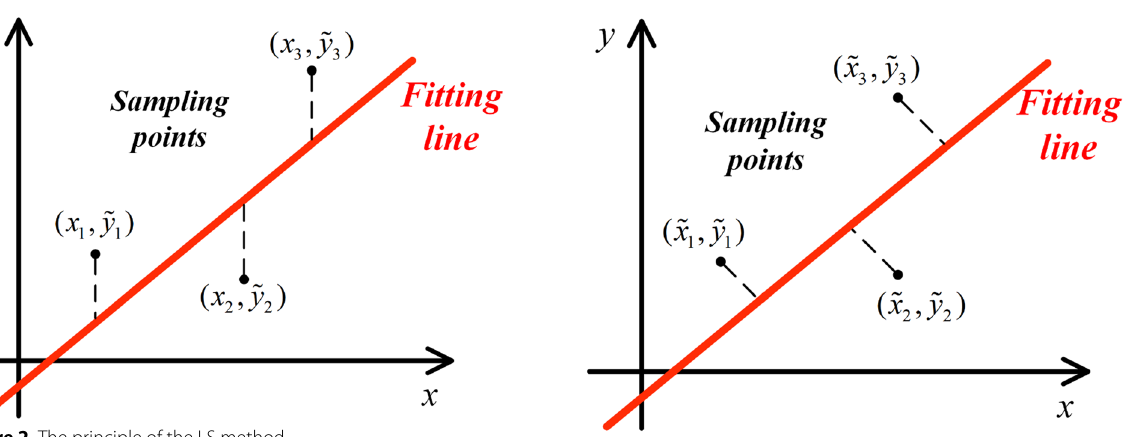
Figure 3 The principle of the TLS